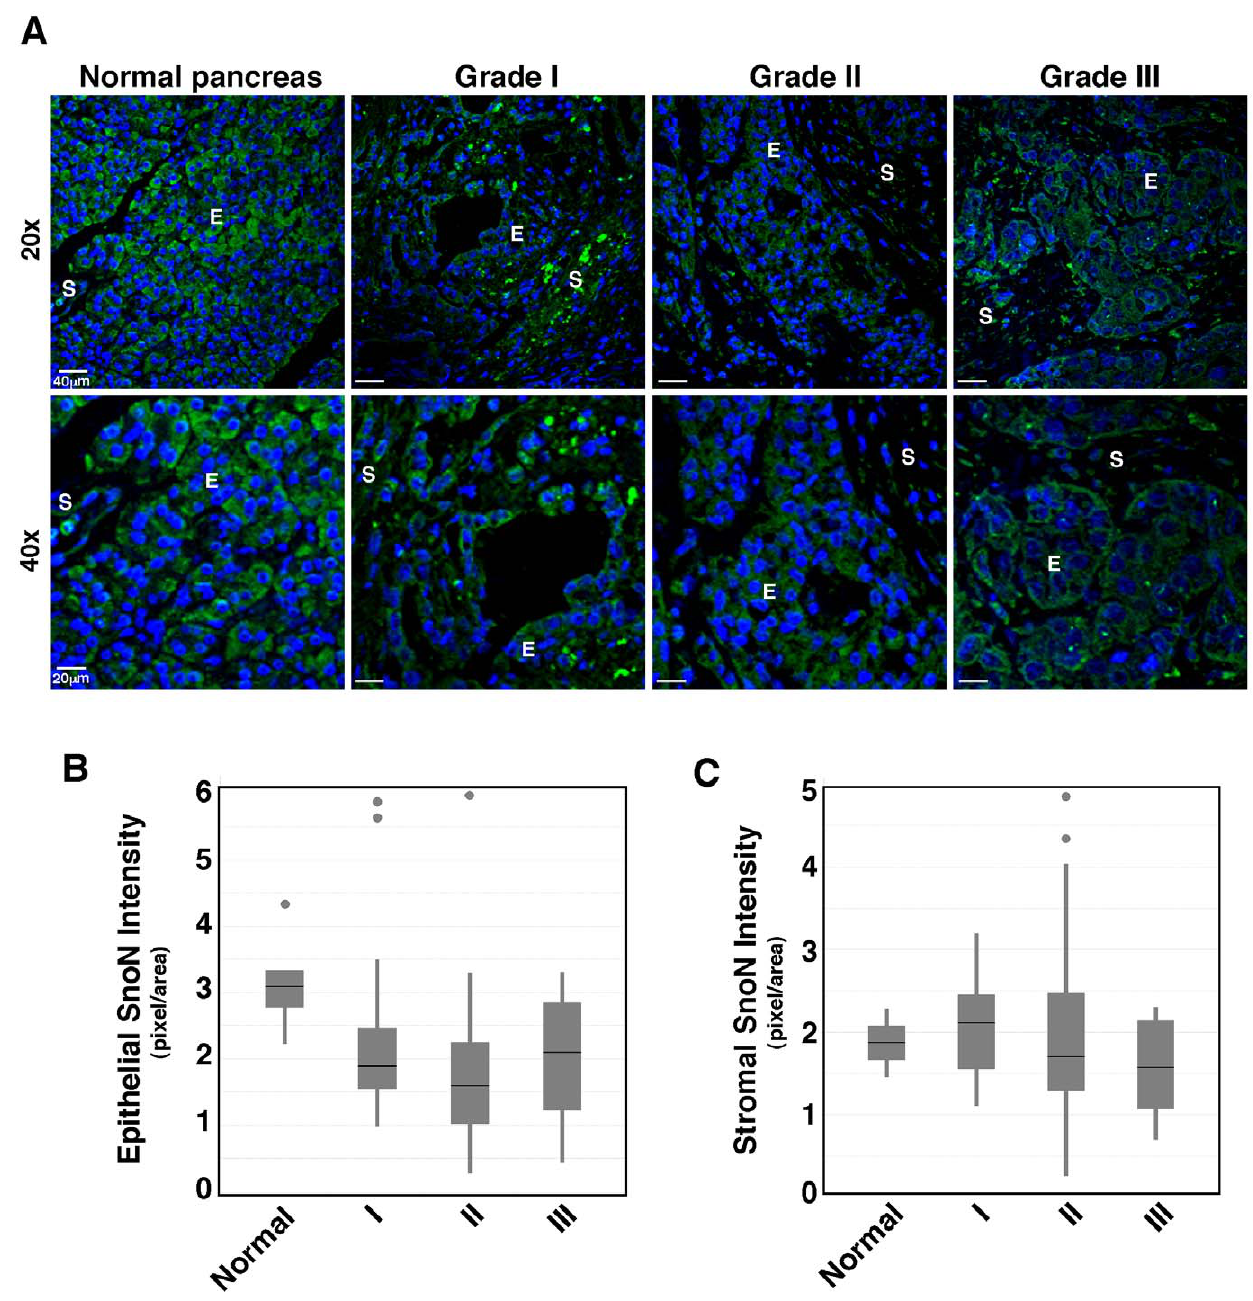
Figure 4. SnoN expression is reduced in pancreatic adenocarcinoma samples. A, Representative SnoN expression in the normal pancreas and in pancreatic adenocarcinoma of varying grades at 20X (top) or 40X (bottom) magnifications. E: epithelium; S: stroma. Green: SnoN; blue, DAPI. B, SnoN staining in normal and pancreatic tumor epithelial cells was quantified using Image J, and the numbers were plotted in the box plot, which includes normal samples (n=5, mean=3.08) and pancreatic tumor samples of grade I (n=21, mean=1.89), grade II (n=59, mean=1.59), and grade III (n=8, mean=2.09). SnoN expression in tumor samples was weaker than that in normal pancreatic samples (p=0.0855 for grade I, p=0.0125 for II, and p=0.0518 for III). No significant difference was observed in SnoN epithelial staining between the pancreatic tumor samples. C, SnoN staining in normal (n=2, mean=1.87) and tumor stromal samples of grade I (n=20, mean=2.10), II (n=55, mean=1.70), and III (n=8, mean=1.57). There is no statistically significant difference between tumor and normal stroma